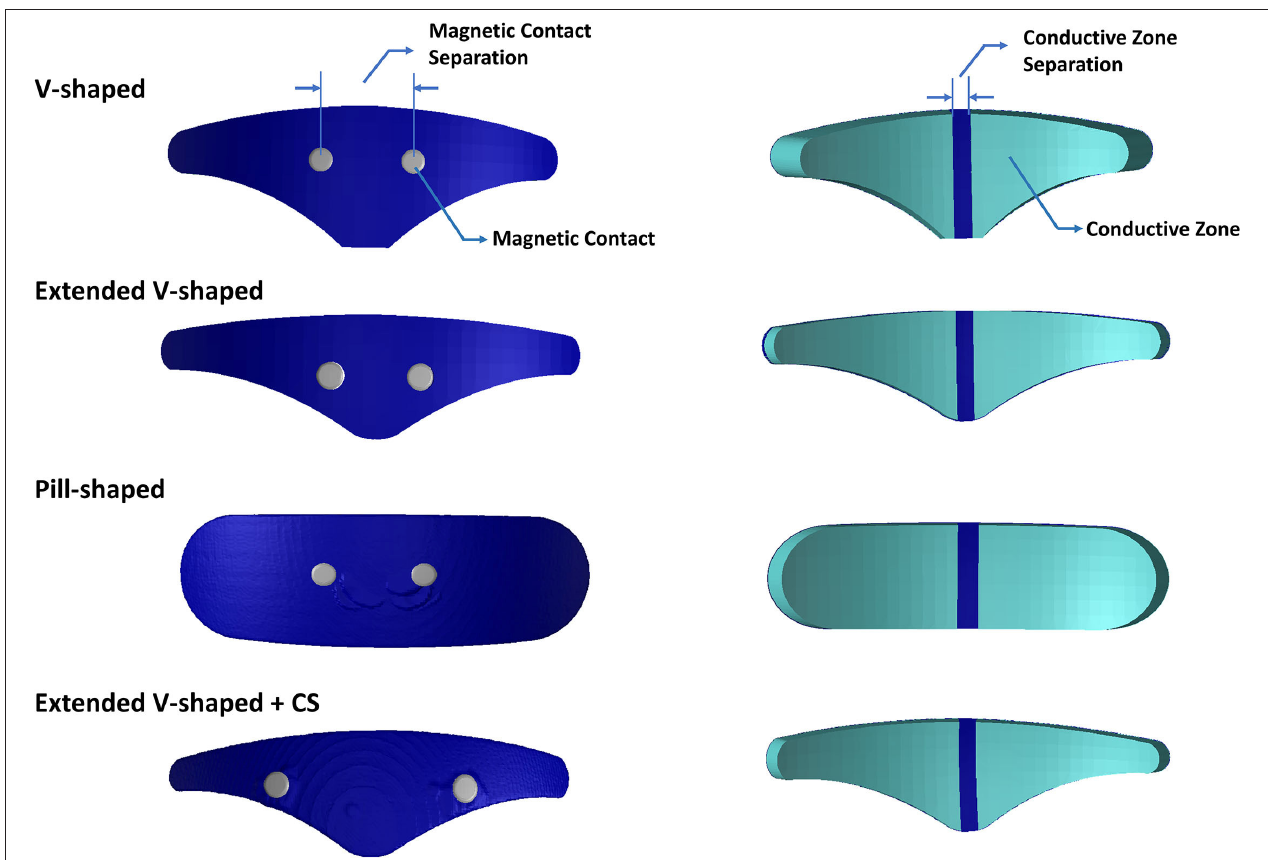
FIGURE 1 | Electrode geometries evaluated in this study. Images on the left indicate the top surface. Images on the right indicate the bottom or patient contacting surface. The V-shaped geometry reflects the clinically approved design, and the extended V-shaped extends 10mm wider but its surface contact area matched the clinically approved design. The pill-shaped geometry reflects an idealized design. The final geometry mimics the extended V-shaped design but has greater contact separation. Each geometry comprises two conductive zones on the bottom surface. The actual dimensions of all geometries are provided in Table 1